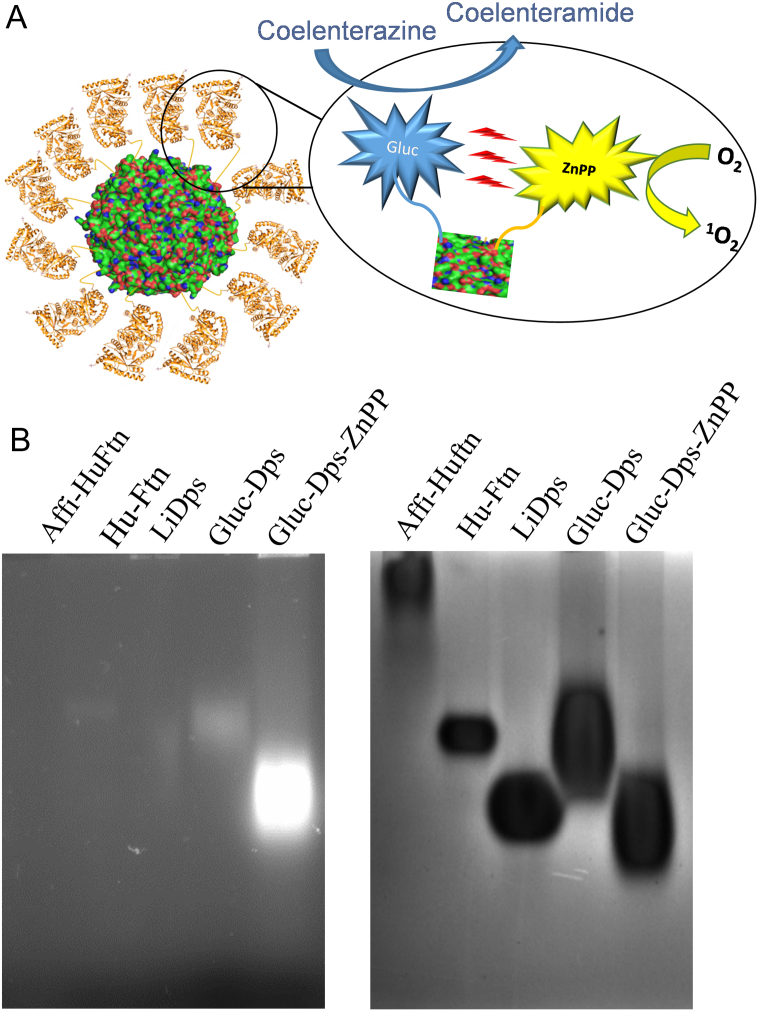
(A) Schematic representation of a mechanism of the structure of Gluc-LiDps-ZnPP and generation of ROS. (B) Photograph of a native agarose gel under UV illumination (λex = 300-400 nm) (left) and stained with Coomassie brilliant blue R-250. Human apo-ferritin (HuAFn) (561 kDa), and LiDps (257 kDa) proteins were used as molecular weight markers after their mass was determined by ESI-MS. Molecular weight of Gluc-LiDps is estimated to be 459 kDa and Gluc-LiDps-ZnPP to be ~515 kDa.